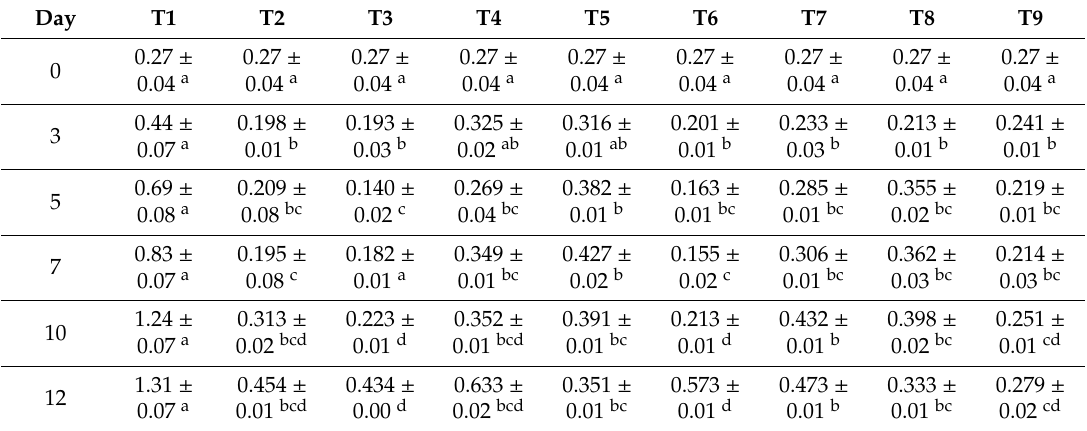
Table 4. Thiobarbituric acid-reactive substance (TBARS) values (mg MDA / kg) in beef patties during 12 days of refrigerated storage at 4 ± 1 ◦